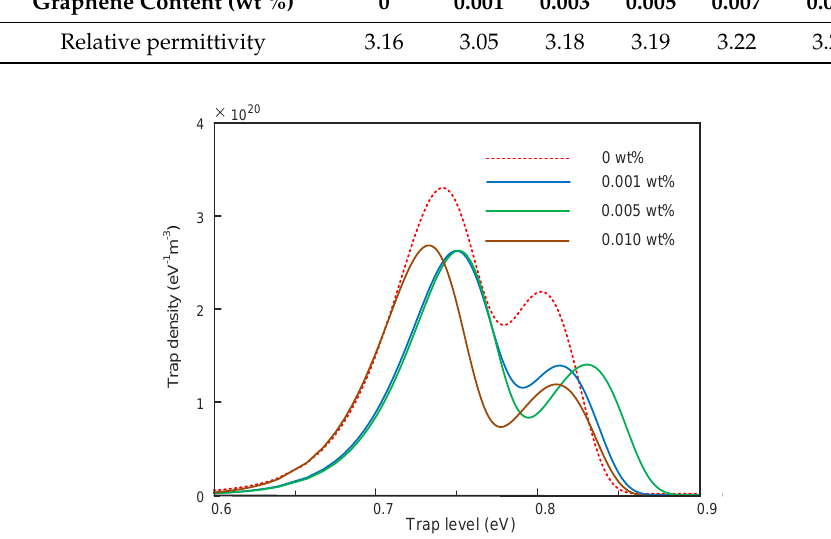
Figure 5. Trap distribution in graphene/silicone rubber nanocomposites. Table 1. Relative permittivity results at different graphene contents.